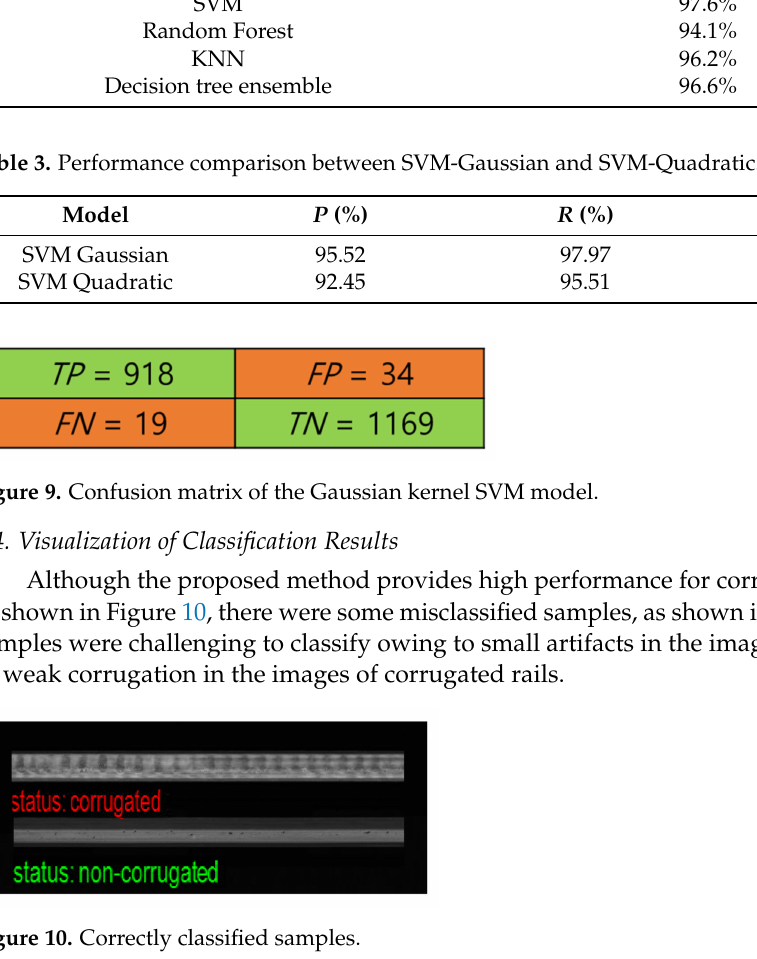
Figure 10. Correctly classified samples.